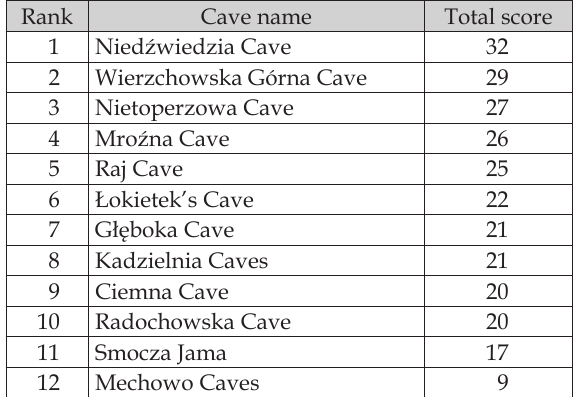
Table 4. Results of the assessment of the attractive - ness as geosites of show caves in Poland.